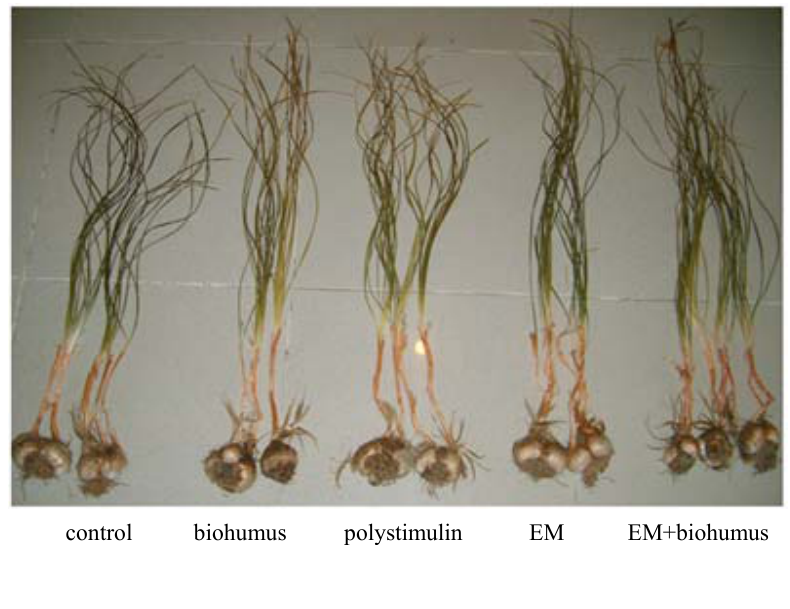
Figure 7 . View of treated and control saffron bulbs.